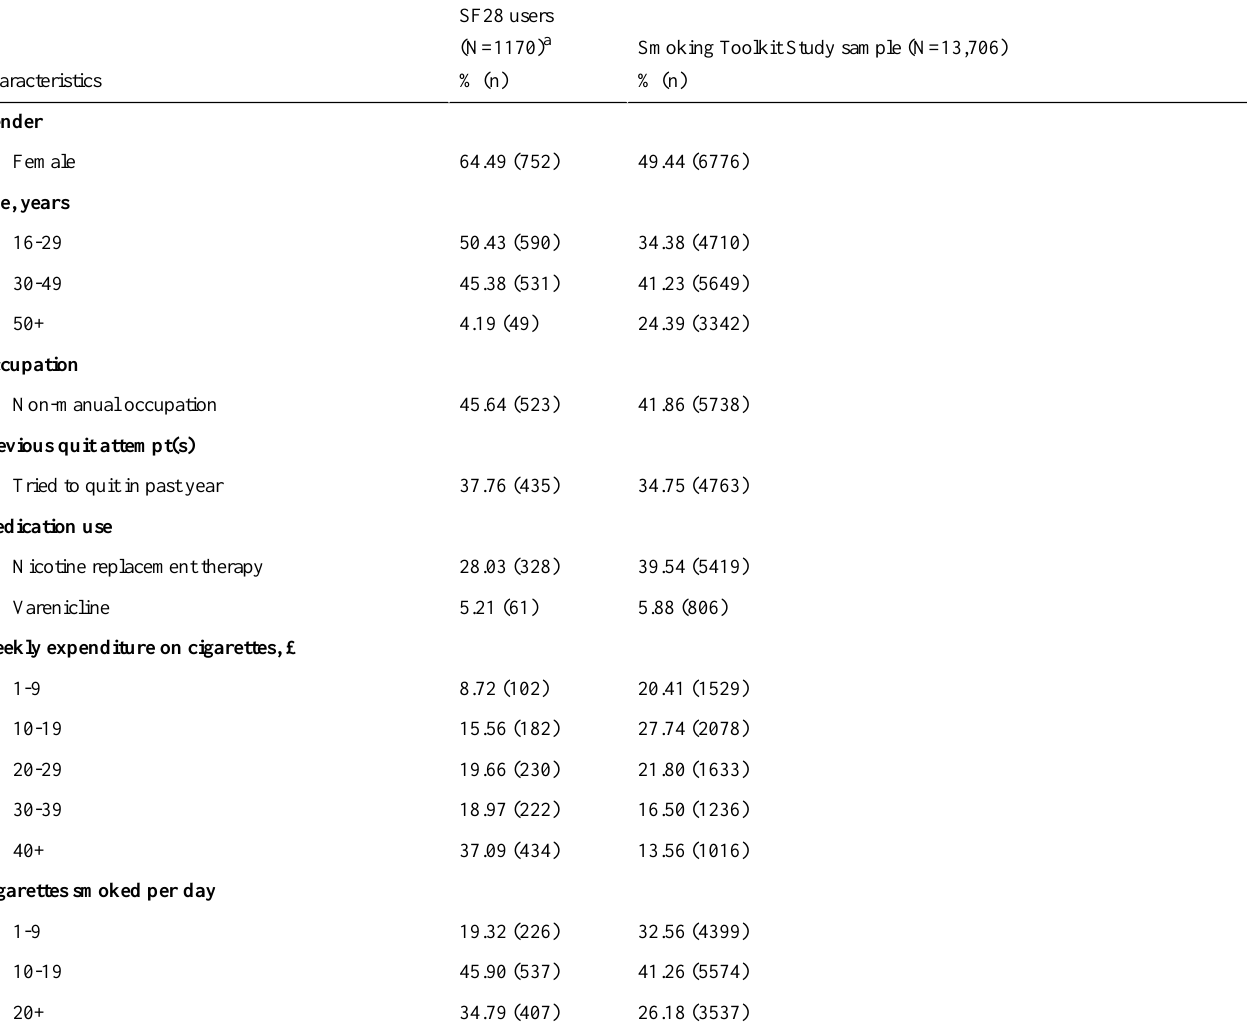
Table 2. Characteristics of participants compared with nationally representative sample of smokers in England who had tried to quit in the past year (all differences apart from varenicline use are statistically significant by chi-square test, P